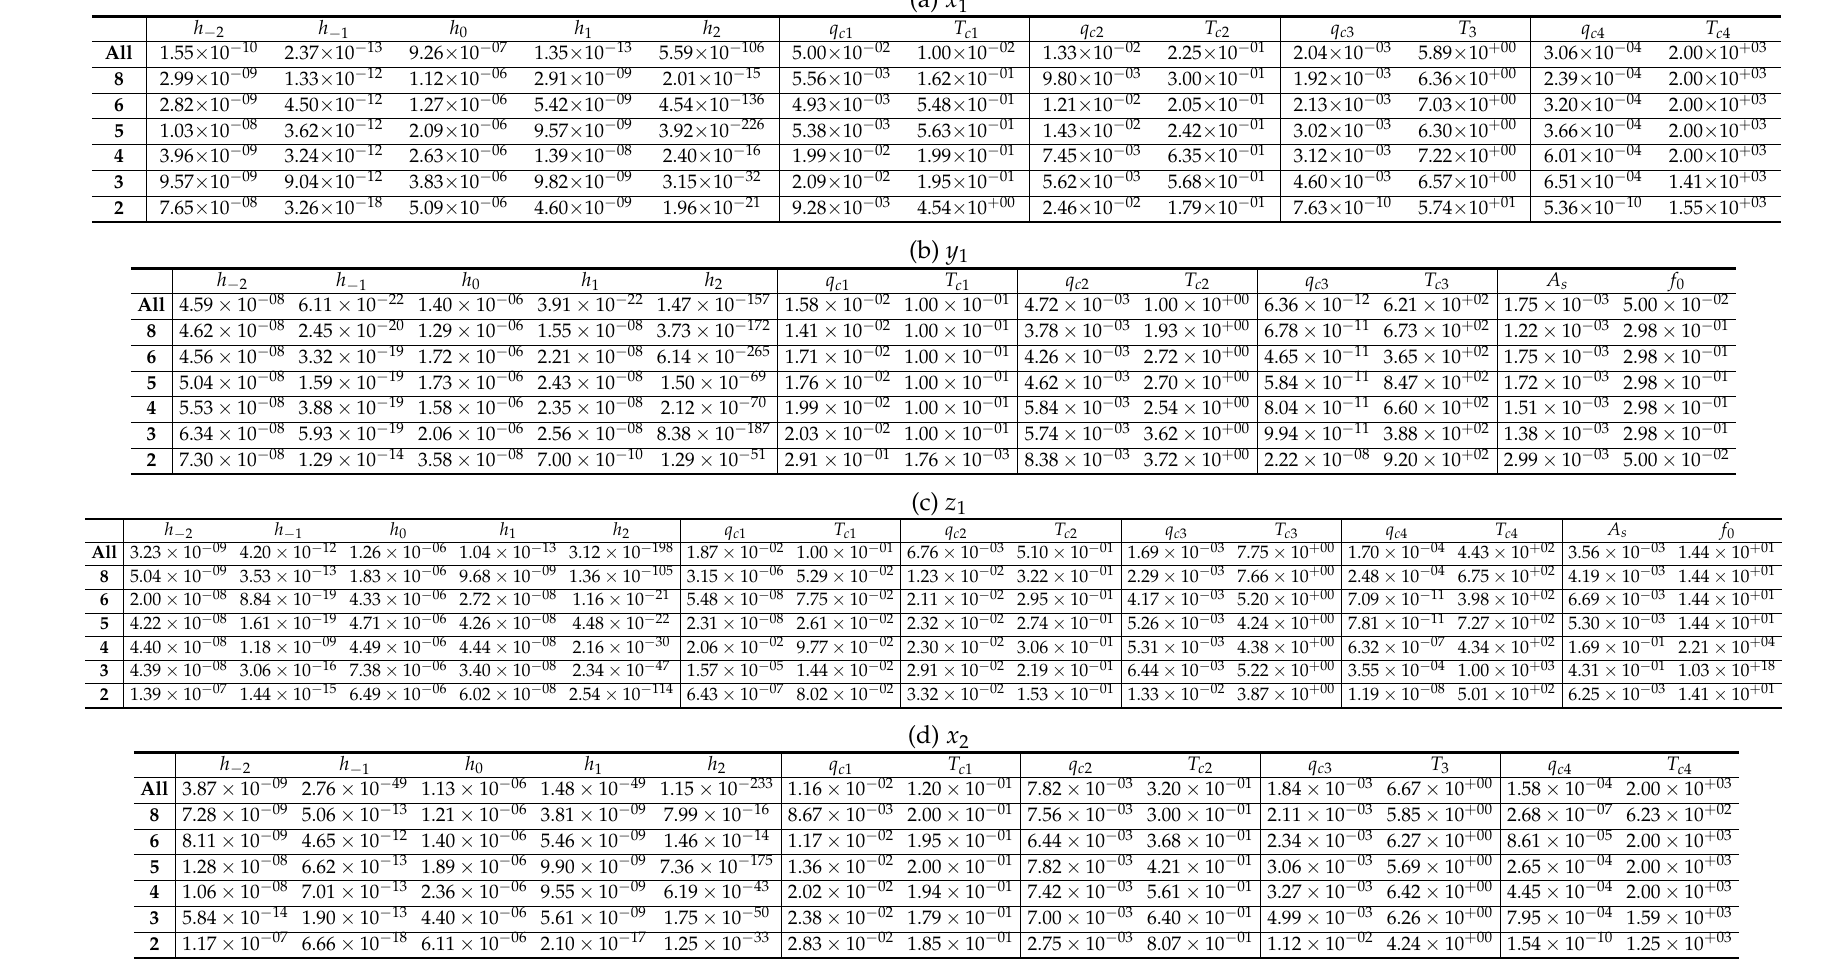
Table A1. Estimated noise parameters of T40 cameras type for 2..10